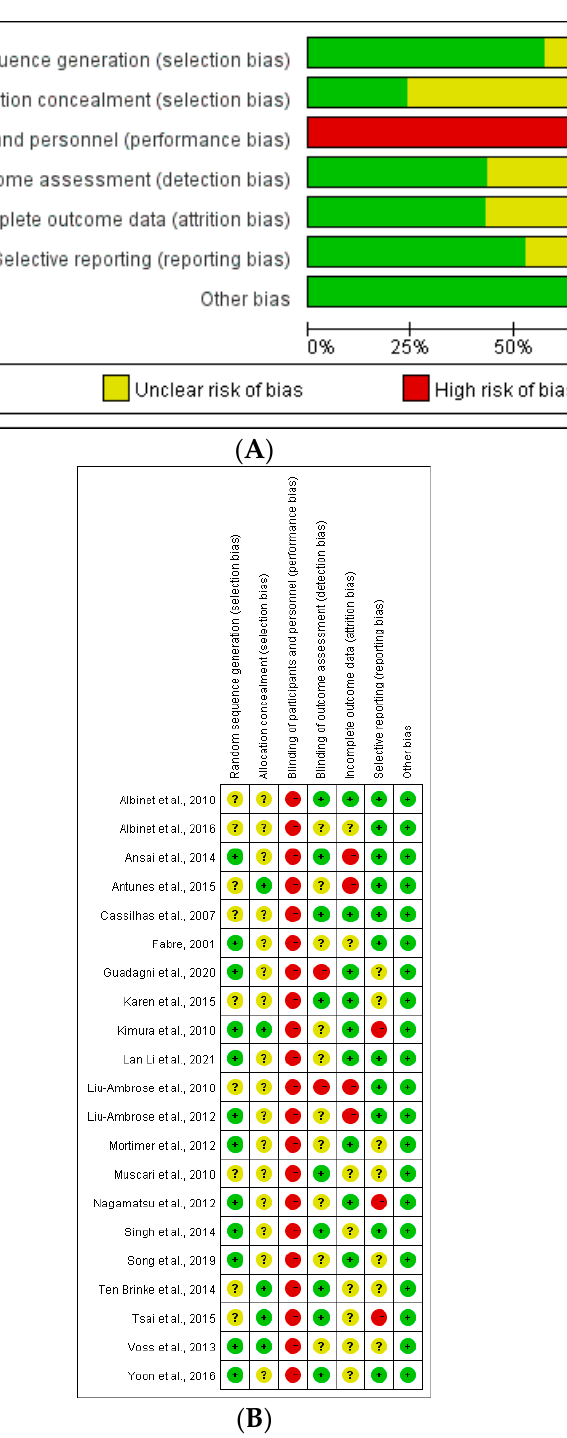
Figure 2. ( A ). Risk of bias summary; ( B ) risk of bias assessments